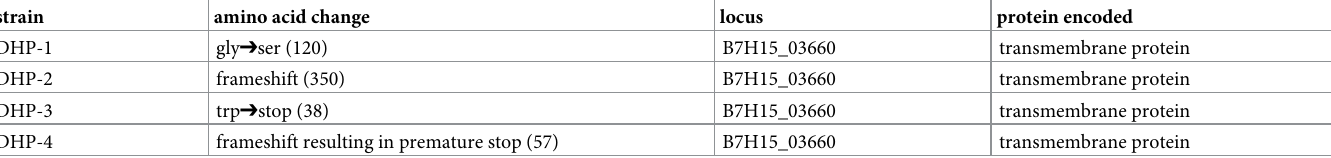
Table 1. Whole genome sequencing of DHP resistant strains.